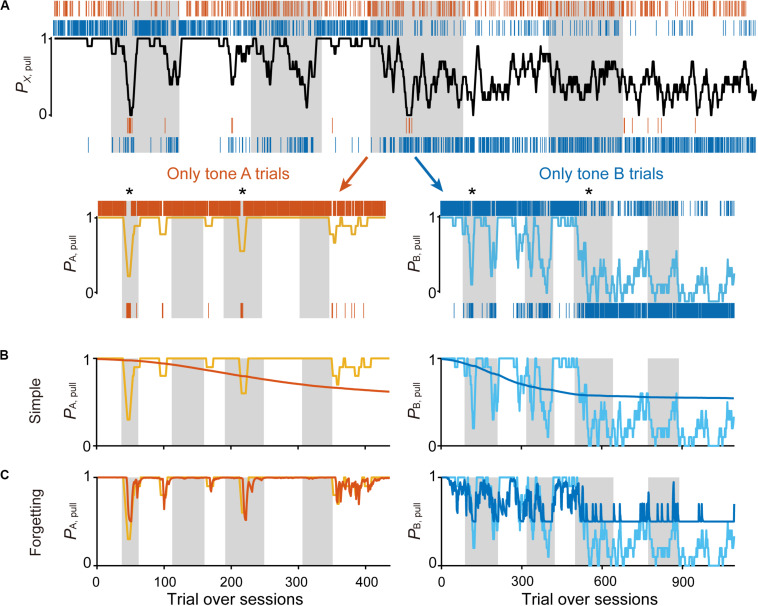
Simple Q-learning model to explain the pull-choice probability. (A) Representative time course of the 10-trial moving-average of the pull-choice across nine concatenated sessions in condition 1 (top), and the time course separated into tone A (bottom, left) and tone B (bottom, right) trials. Even sessions are shaded. Asterisks indicate short periods in which the pull-choice probability decreased in both tone A and B trials. (B,C) Representative predicted pull-choice probability of the simple (B) and forgetting (C) models in tone A (left) and B (right) trials. Orange and cyan traces represent the 10-trial moving-average of the actual pull-choice [the same as in (A)]. Red and blue traces represent the predicted pull-choice probability.